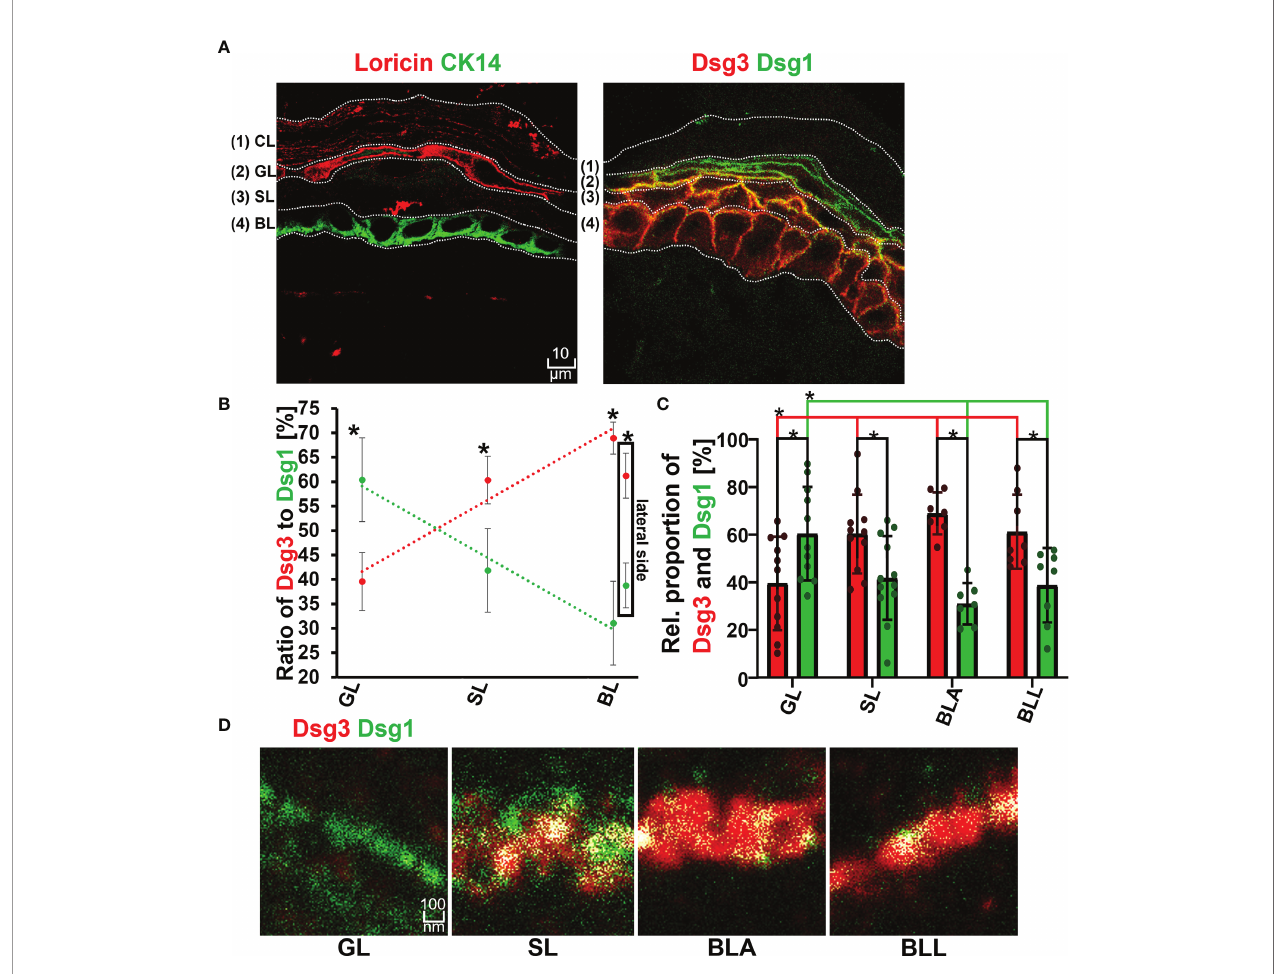
FIGURE 2 | (A) Confocal microscopy images showing the identi fi cation of layers by staining of Loricin (red) and Cytokeratin 14 (Ck14 green) on the left and distribution of Dsg1 (green) and Dsg3 (red) along the epidermal layers and right. (B) Relative proportion of Dsg1 and Dsg3 along the different epidermal layers. (C) quanti fi cation of relative stained area of Dsg1 and Dsg3 along the epidermal layers. (D) STED microscopy images of the double staining borderof Dsg3 (red) and Dsg1 (green) at a single cell border, along the different epidermal layers. N (body donors)=3, n (cell borders)=2-7. *Signi fi cant difference to the value which is indicated that it is compared